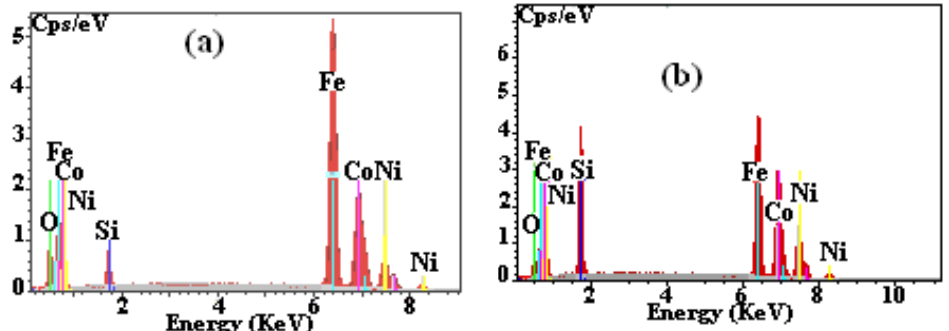
Figure 2. EDS spectra of milled (100 h) powdered alloys: Fe 55 Co 25 Ni 15 Si 5 ( a ) and Fe 30 Co 25 Ni 15 Si 30 ( b ).